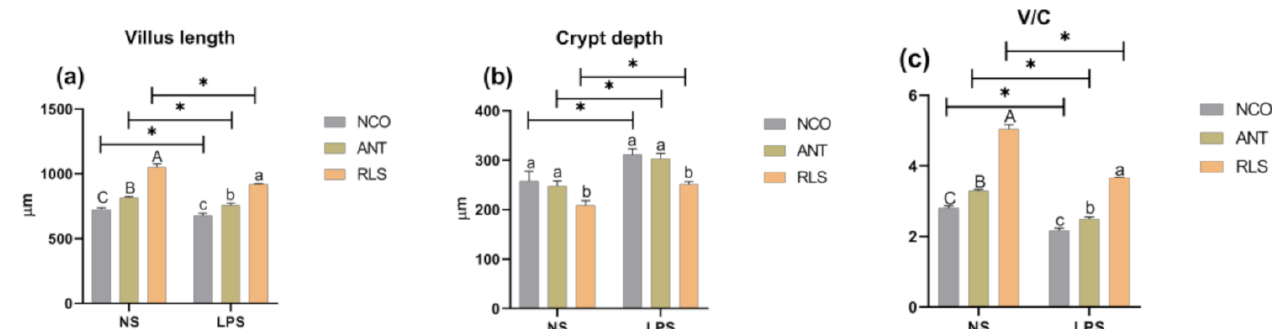
Figure 1. Effects of RLS on jejunum morphology in broilers challenged with LPS. ( a ) Effect of RLS on villus length. ( b ) Effect of RLS on crypt depth. ( c ) Effect of RLS on villus height/crypt depth ratio (V/C). NS-NCO represents control broilers treated with normal saline. NS-ANT represents broilers treated with the antibiotic; NS-RLS represents broilers treated with rhamnolipids; LPS-NCO represents control broilers challenged with LPS; LPS-ANT represents broilers treated with the antibiotic and challenged with LPS; LPS-RLS represents broilers treated with rhamnolipids and challenged with LPS; * and different superscript letters indicate significant differences ( p < 0.05), majuscule present NS-groups and lowercase present LPS-groups, n = 6.